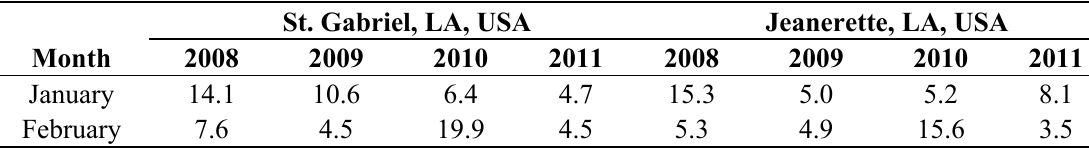
† Indicates the information is not available for this month due to malfunctioning weather sensors. Table 2. Average monthly precipitation (cm) observed in 2008–2011 for St. Gabriel and Jeanerette,